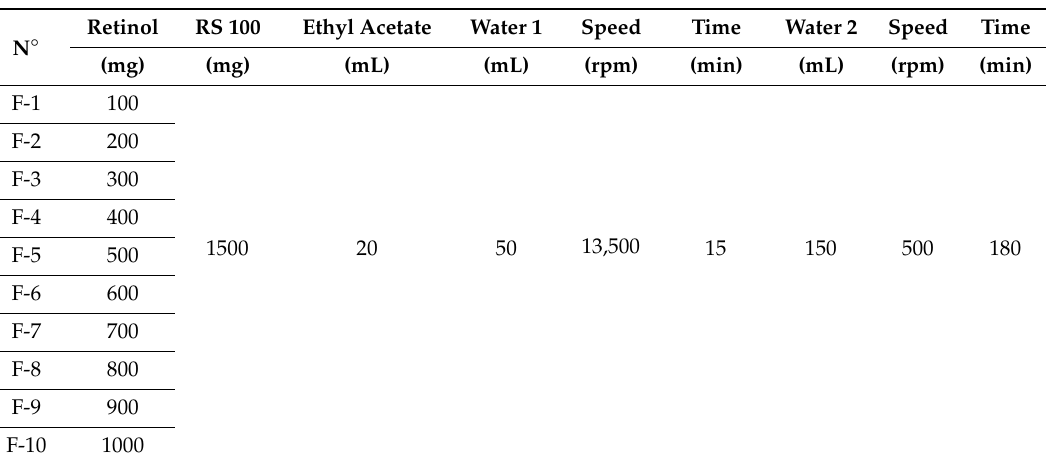
Table 2. Compositions of the prepared nanoparticles.